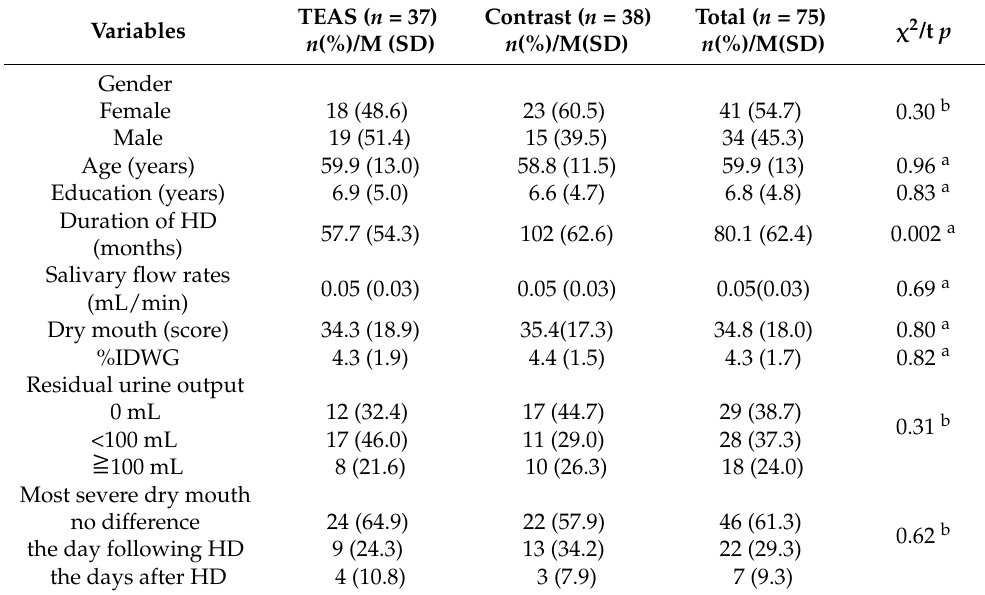
Table 1. Demographic and clinical characteristics ( n =